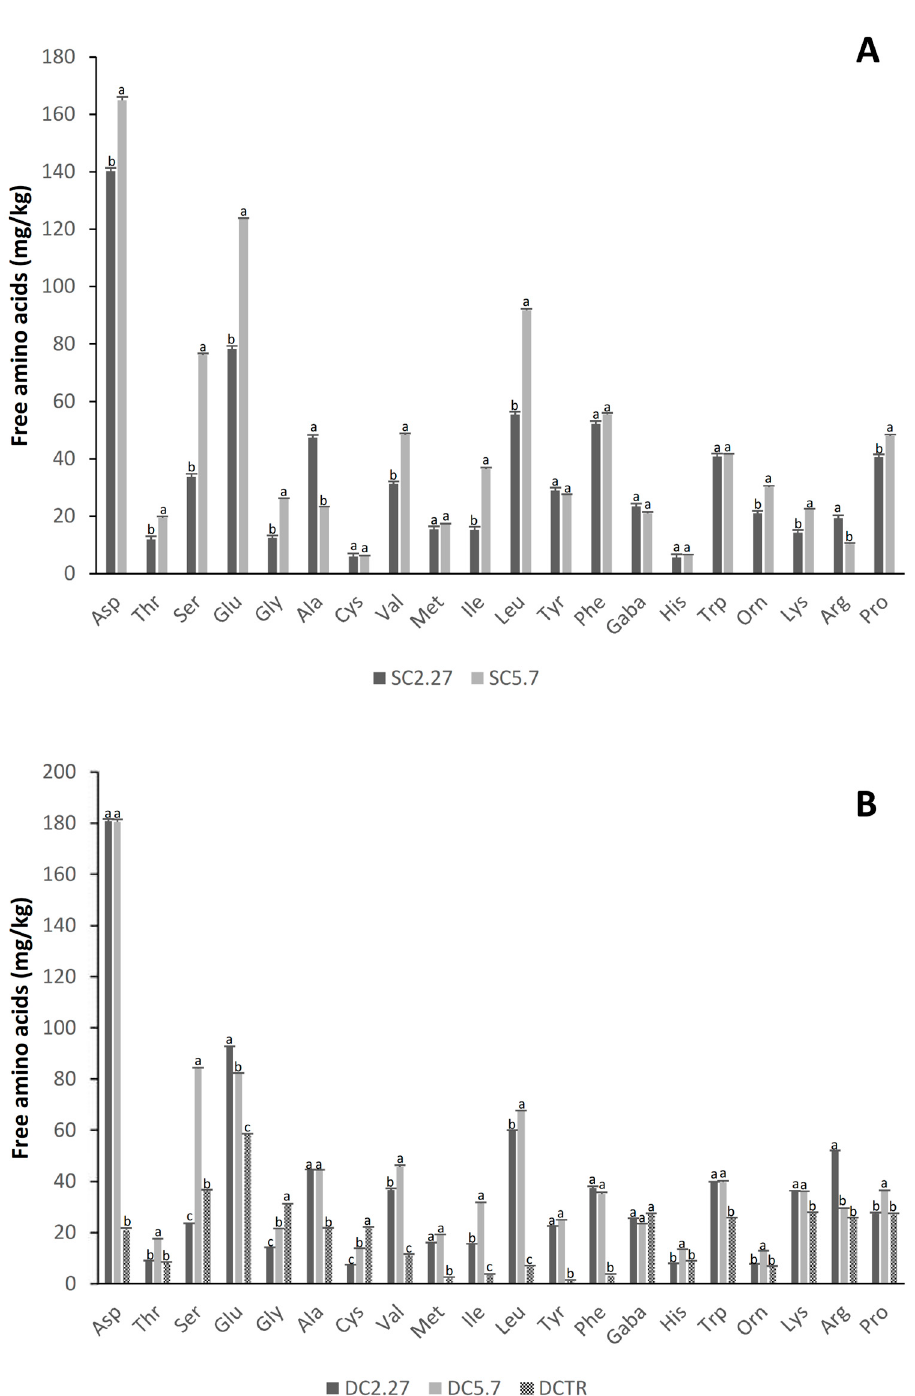
Figure 2. Concentration of free amino acids and their derivatives (mg/kg) in liquid sourdoughs (S C2.27 and S C5.7 ) inoculated with starter strains ( A ) and bread doughs obtained with liquid sourdough (D C2.27 and D C5.7 ) or with baker’s yeast (D CTR ) ( B ) in laboratory tests. Data are the means of three independent analyses. The three-letter amino acid code (IUPAC) is used. a–c Values with different superscript letters within the same amino acid differ significantly ( p < 0.05). Bars of standard deviation are also represented.